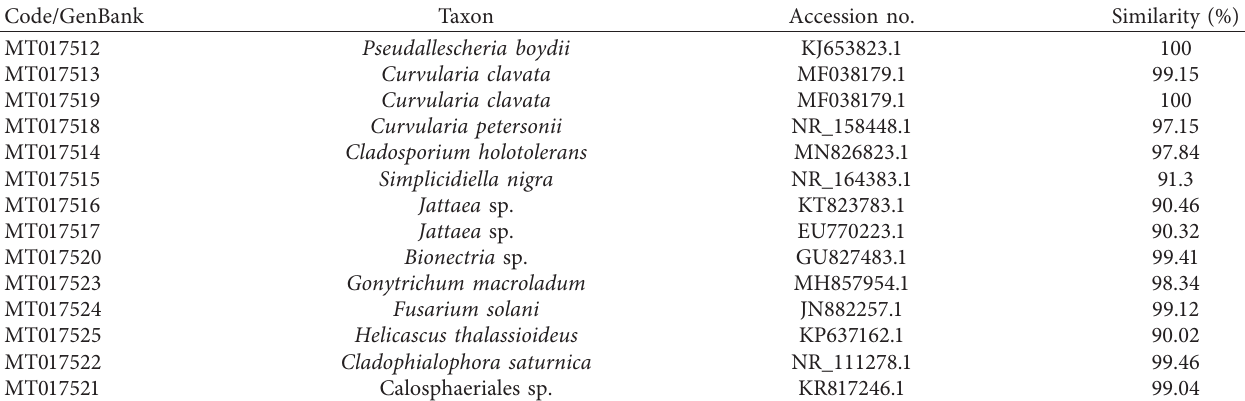
Figure 2: Collection site of Lake Ju´a (a). Collection site of Lake Maic´a (b). Wood samples (c). Ascomata on a wood surface (d). Asci in the water of Dothideomycetes sp. (e). Colonies on MEA after 14 days at 25 ° C (f). Culture in PYG agar (g). Table 1: Strain code and similarity (ITS Barcode) of 14 taxa isolated from samples of submerged wood collected in the Lakes Ju´a and Maic´a, Santar´em, Par´a,